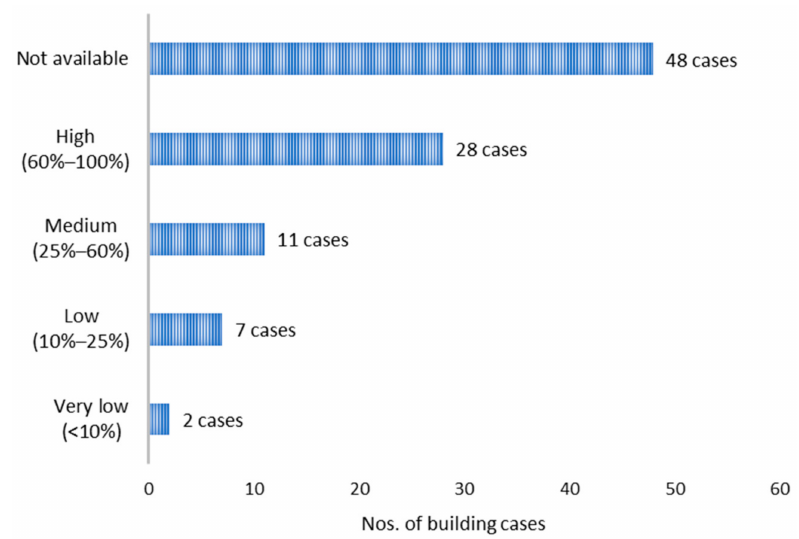
Figure 6. Level of fabrication of the reviewed prefabricated building